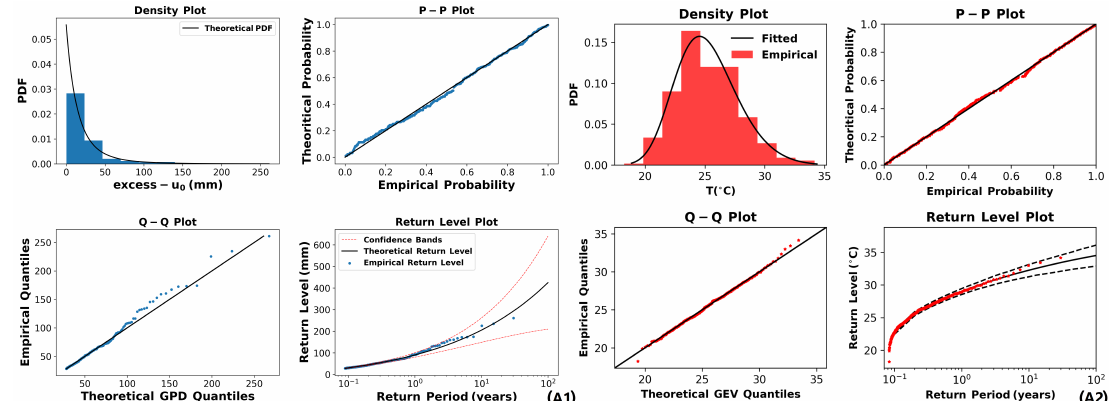
Figure A5. Diagnostic plot for Acri station. ( A1 ) Rainfall diagnostic plot. ( A2 ) temperature diagnos- tic plot.